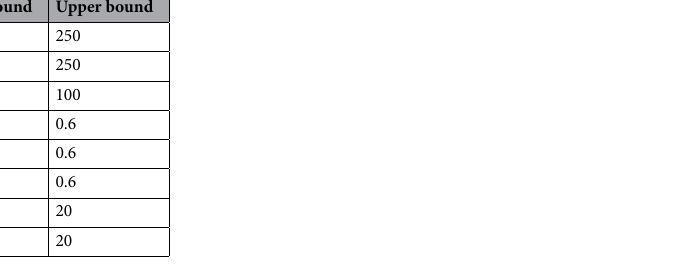
Table 2. Design factors of DOE and the